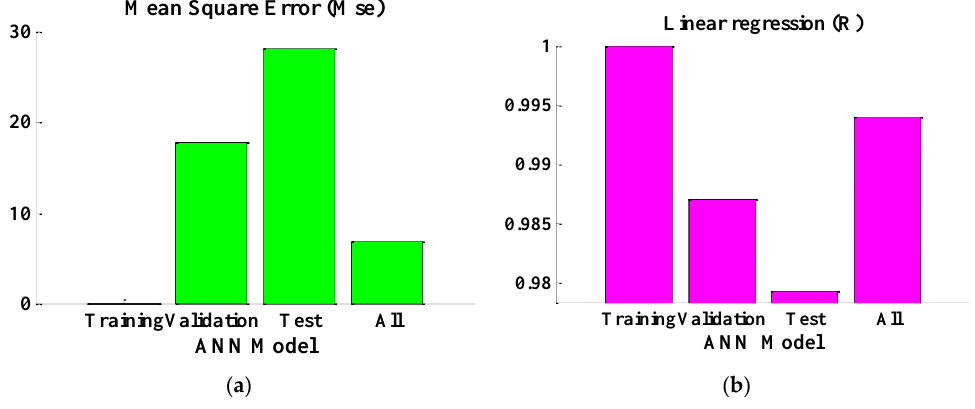
Figure 5. The obtained values of the correlation coefficient and the sum of the squared errors in a network with 2 hidden layers and 31 neurons. ( a ) mean square error; ( b ) linear regression.